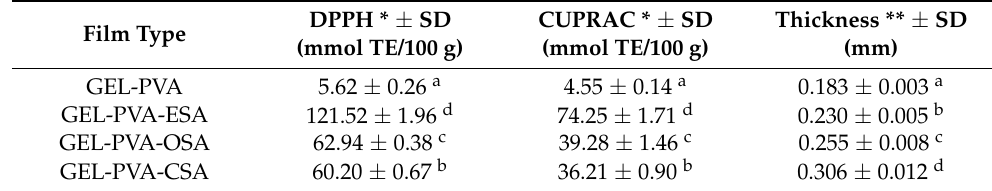
Table 1. Antioxidant activity and thickness of the prepared